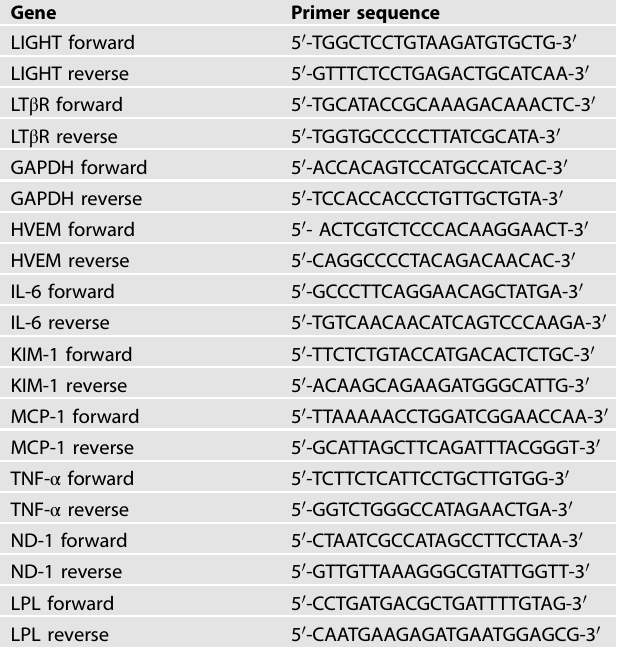
peroxidase-labeled goat anti-rabbit/mouse secondary antibodies (1:800, Beyotime, Shanghai, China) for 1 h at 25 °C. Following washing three times with PBS, 3,3 ’ -diaminobenzidine chromogen solution (DAB, Beyotime, Shanghai, China) was used for visualization, and the sections were